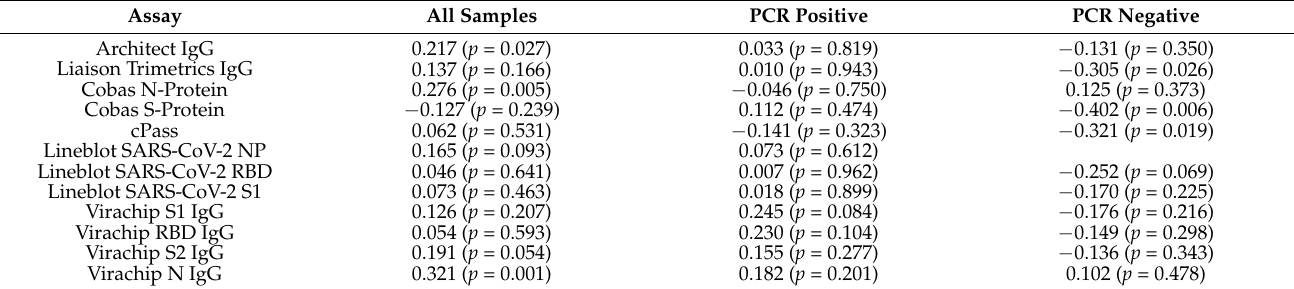
Table A2. Spearman correlation coefficients between all individual assays and age.